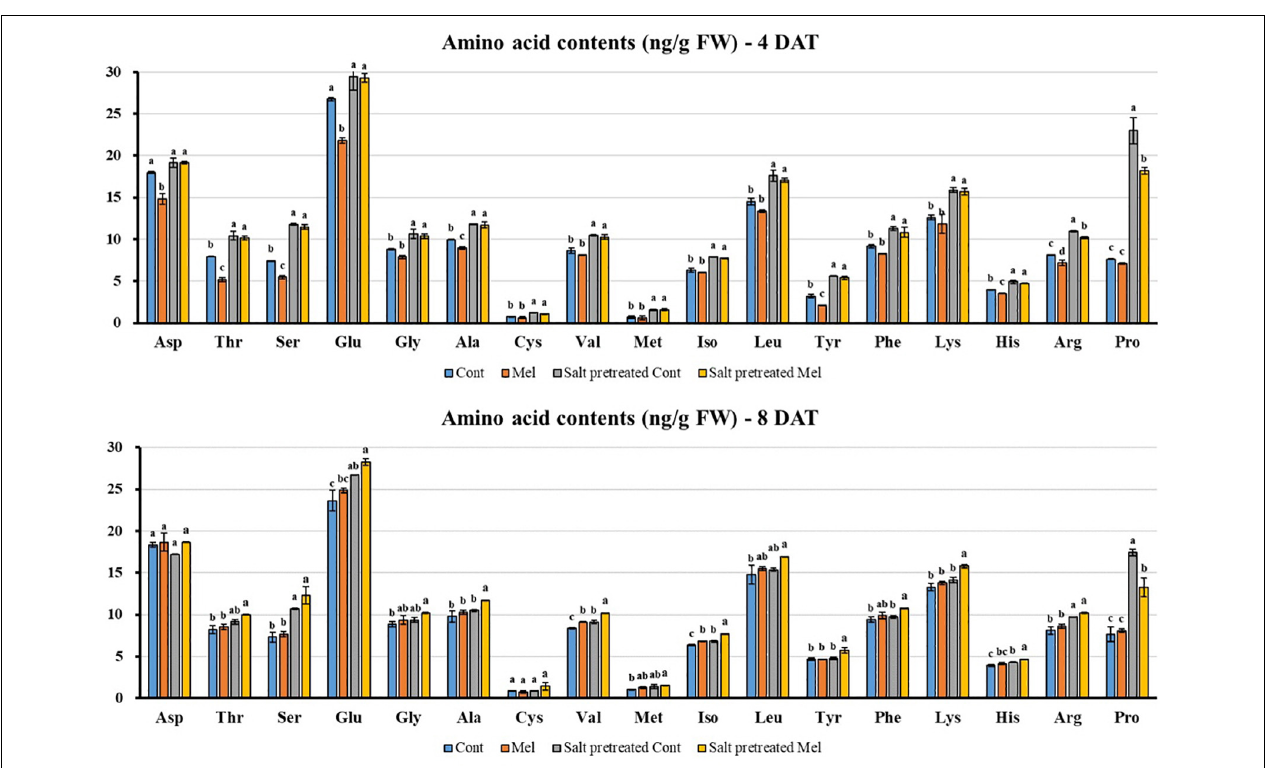
FIGURE 9 | Effect of melatonin with/without salt stress on amino acid content in green mustard seedlings. The results were calculated from data for 4 (4DAT) and 8 (8DAT) days. Treatment: control + water, control + 1 µ M melatonin, 150 mM salt pre-treatment + water, 150 mM salt pre-treatment + 1 µ M melatonin. Values show the means ± SE ( n = 3). Letters represent significant differences at p < 0.05 in accordance with Duncan’s multiple range